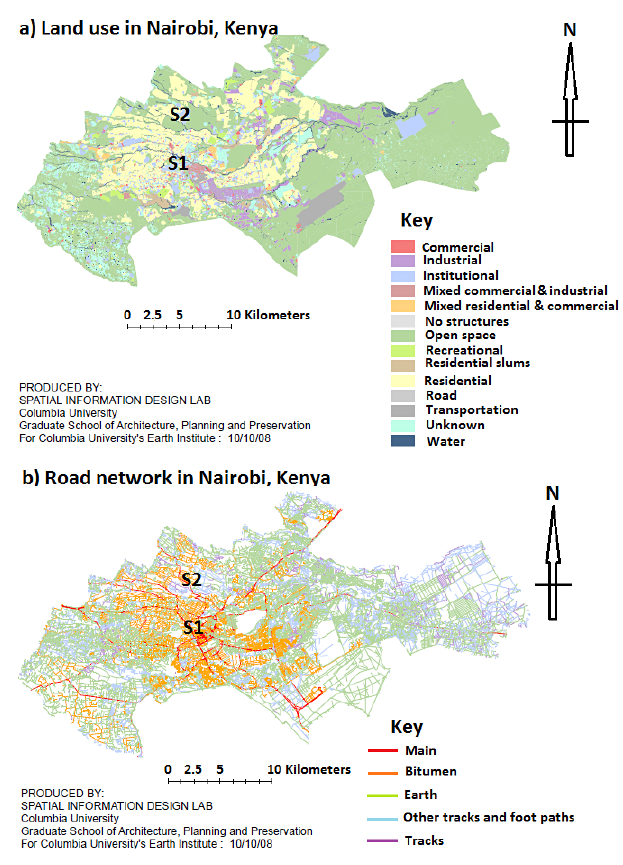
Figure 1. GIS map of the Nairobi metropolitan area showing land use pattern (a) and transportation network (b) . Original maps were modified to include sampling sites as shown on both maps – University of Nairobi (S1) and United Nations Environmen- tal Programme (UNEP) headquarters (S2). Original maps were downloaded from the Center for Sustainable Urban Development’s Nairobi GIS maps and database website (CSUD,